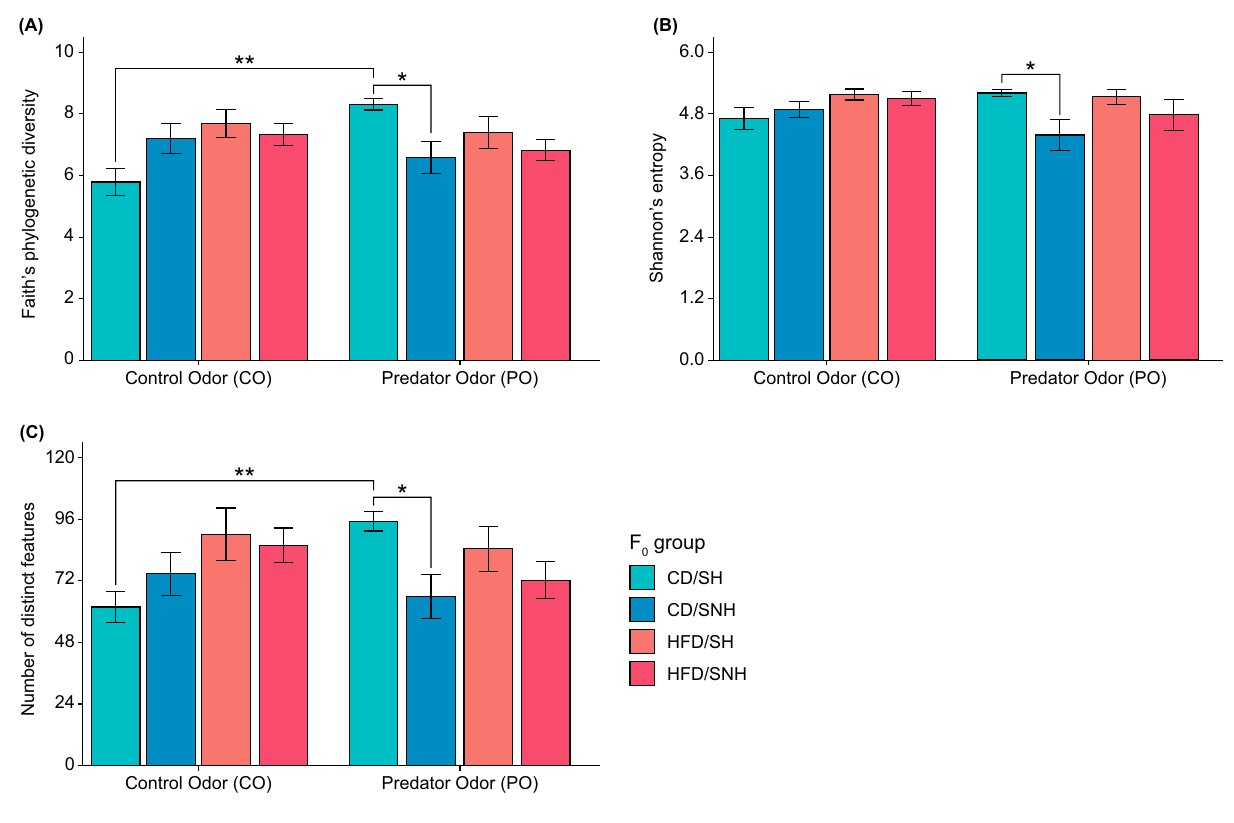
Figure 3. Within-subjects fecal microbiome analyses of alpha-diversity among F 1 offspring are dependent on paternal F 0 conditions. Analyses of alpha-diversity as measures of microbial richness include. ( A ) Faith’s phylogenetic diversity, ( B ) Shannon’s entropy, and ( C ) number of distinct features. Bars represent means ± standard errors of the means for each group. Three-way linear mixed-effects models evaluating individual and interaction effects of paternal diet, maternal housing, and stress exposure conditions were performed on 16 small subunit ribosomal RNA (16S rRNA) gene V4 amplicon data at a rarefaction depth of 3,136 reads per fecal sample collected from individual F 1 offspring in the test arena at the conclusion of the predator odor exposure (OE) test, just before sacrifice. CD control diet, HFD high-fat diet, OE odor exposure, SH standard housing, SNH semi-naturalistic housing. ** p < 0.01, *** p < 0.001, pairwise Wilcoxon rank-sums tests without multiple corrections.